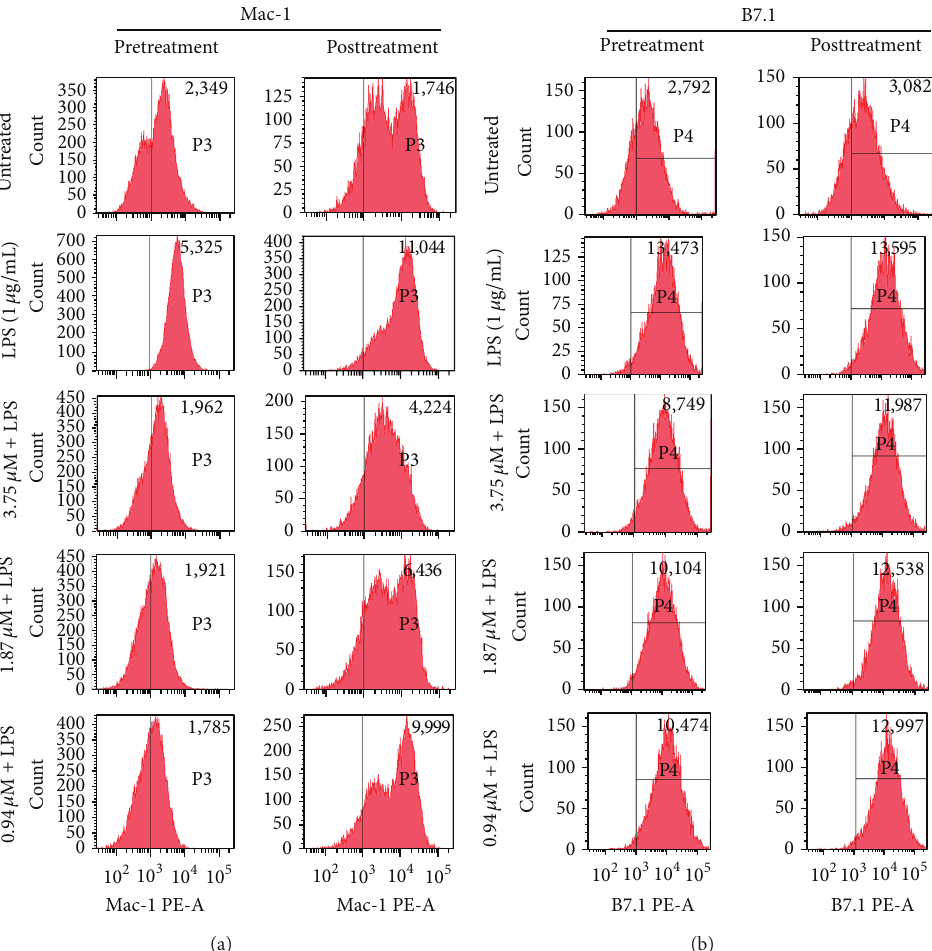
Figure 5: Effects of pyrenocine A on the expression of Mac-1 and B7.2 by macrophages. Pretreatment procedure: cells were pretreated with different concentrations of pyrenocine A (3.75–0.94 𝜇 M) for 2 h and then stimulated with LPS (1 𝜇 g/mL) during 18h. (b) Posttreatment procedure: cells were stimulated with LPS (1 𝜇 g/mL) for 2h and then pyrenocine A was added (3.75–0.94 𝜇 M) during 18h. The expression of surface receptors such as Mac-1 and B7.1 was evaluated by MIF and by measuring the percentage of positive cells, respectively. All samples were analyzed using flow cytometry and a FACSCanto machine with BD FACSDiva software. Results are representative of three independent